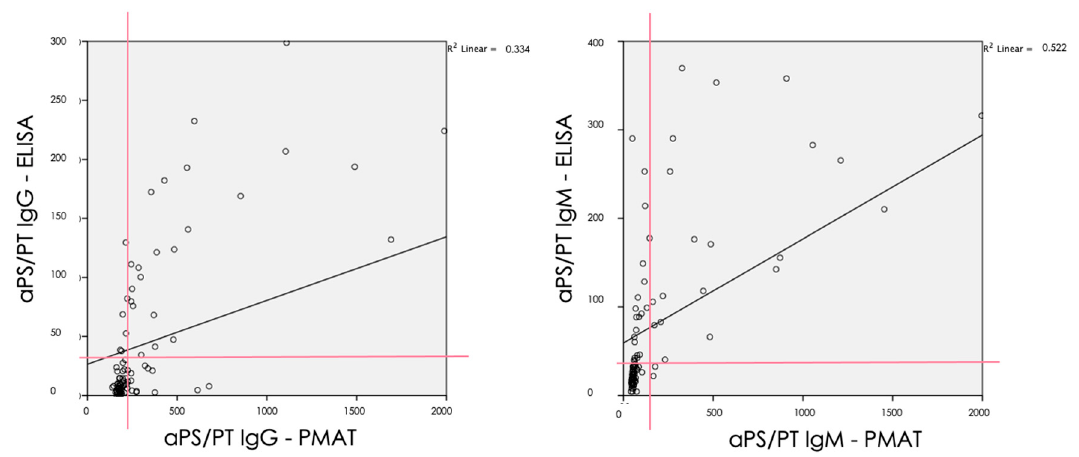
Figure 2. Correlation analysis with the Spearman Model of aPS/PT (IgG and IgM) antibodies between ELISA and PMAT. aPS/PT means antiphosphatidylserine/prothrombin antibodies; ELISA, enzyme-linked immunosorbent assay.